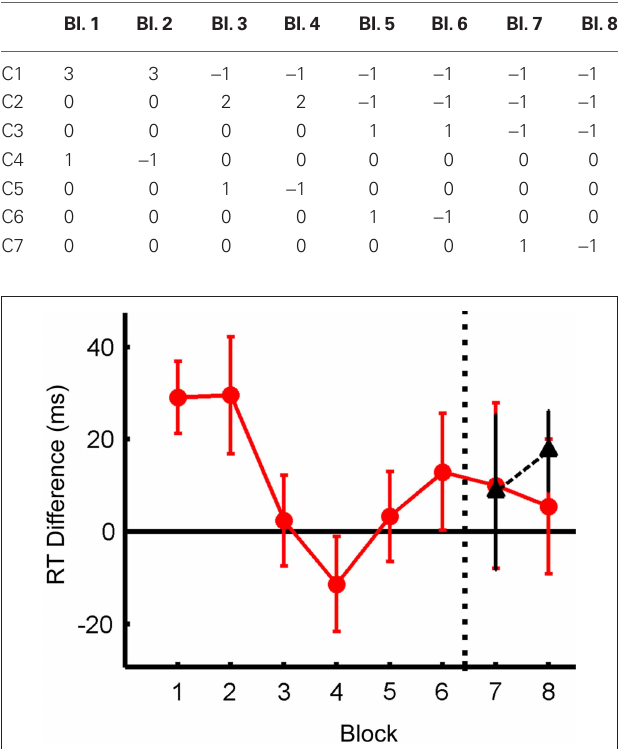
FIguRe 4 | Behavioral effect of distractor across blocks, measured as difference in RT; positive values indicate increased RT in the presence of distractors. Dashed black line indicates point at which new distractor locations were introduced in this figure and all later figures. Red: data for old distractor locations; black: data for new distractor locations.